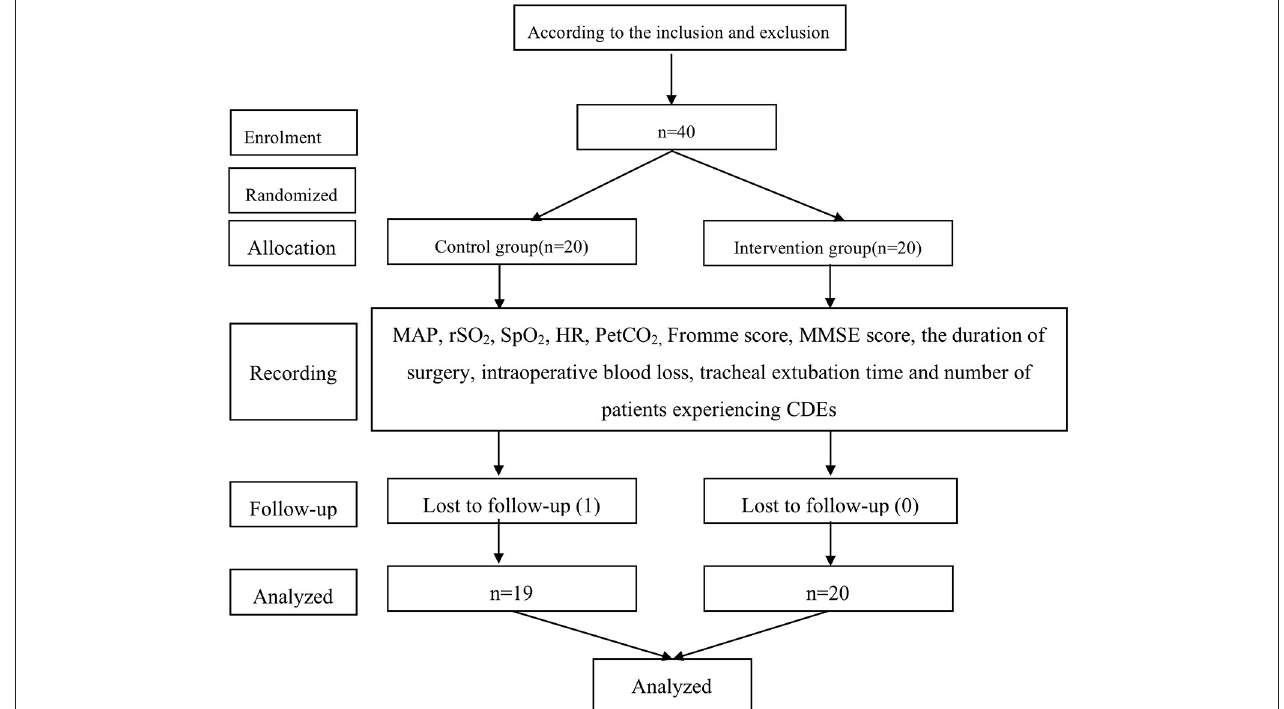
FIGURE 1 | Study flowchart.